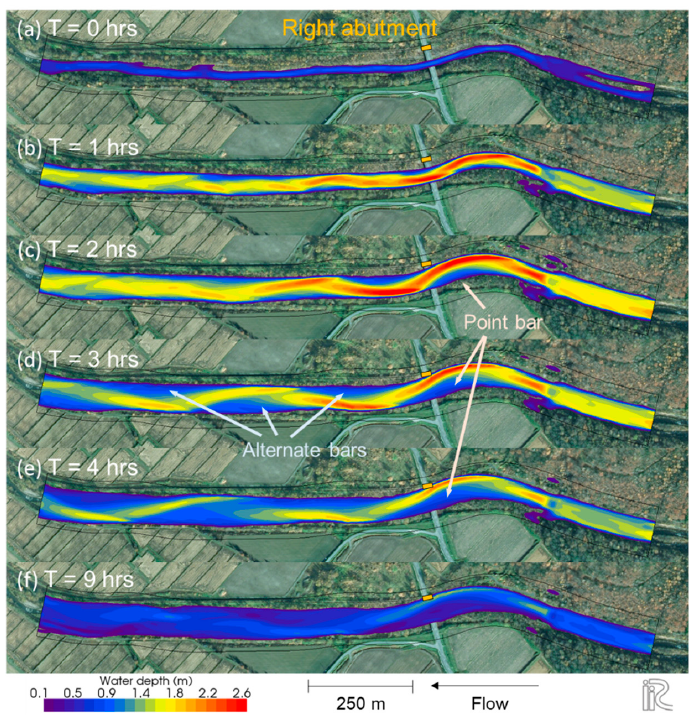
Figure 5. Temporal variation of water depth. A point bar and alternate bars formed upstream and downstream of the Kyusen bridge, respectively. The yellow square indicates the right abutment.